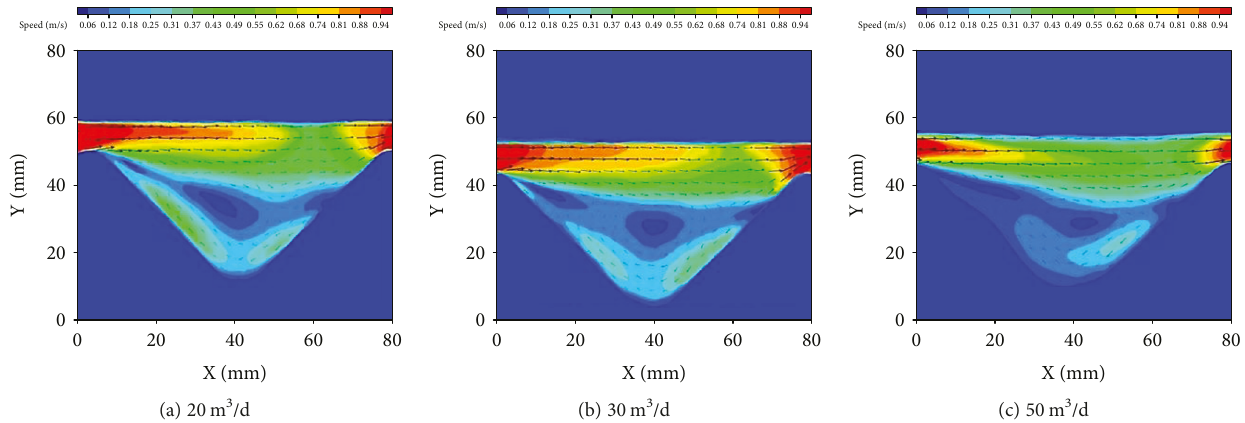
Figure 6: Velocity nephograms of di ff erent fl ow rate of polymer solution fl owing through the partially pressured injection tool.